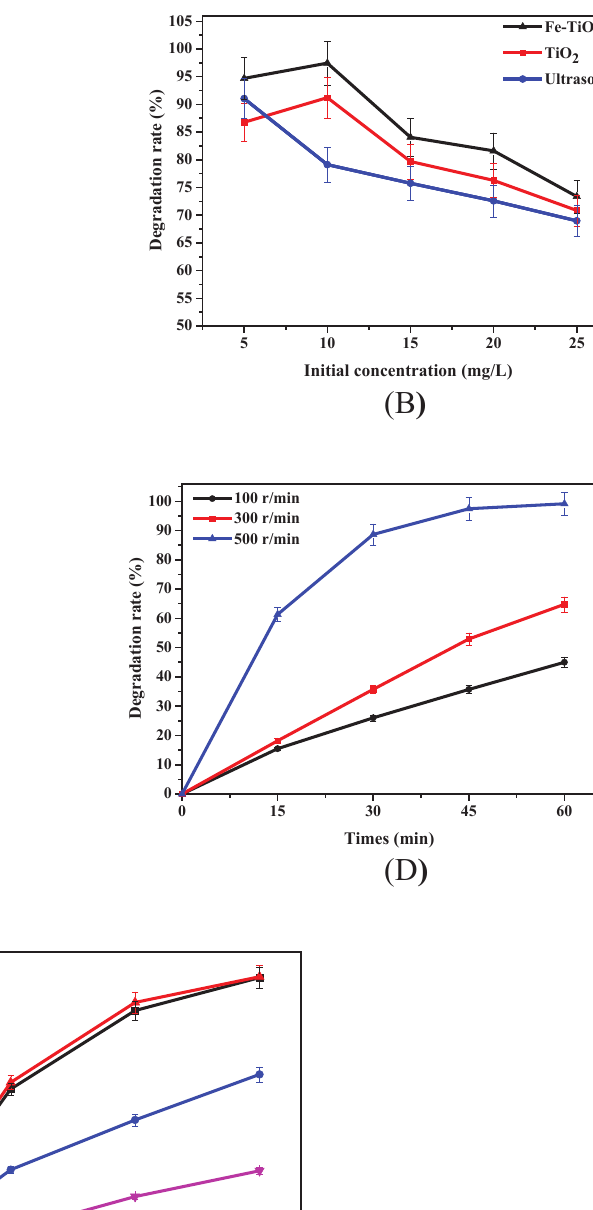
Cycle number Figure 8: (A): Effect of the sunlight and physical adsorption on the degradation by Fe-doped TiO 2 powder (a: the reaction in the sunlight, b: the reaction in the dark, c: the adsorption amount test of dye on Fe-doped TiO 2 ). (B):